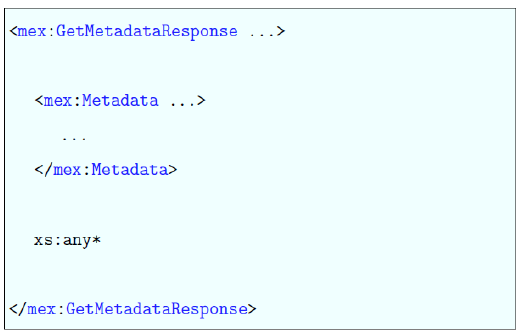
Figure 3. The <GetMetadataResponse> Element.